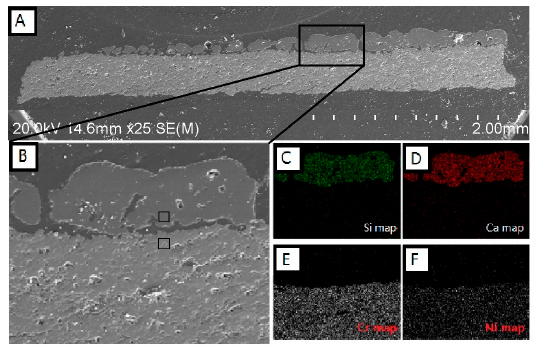
Figure 2. ( A ) Cross-sectional SEM micrographs of APS NiCr 2 O 4 coating that interacted with 35 mg/cm 2 CMAS at 1200 °C for 24 h; ( B ) Higher magnification image of CMAS-NiCr 2 O 4 boundary and its ( C ) Si; ( D ) Ca; ( E ) Cr and ( F ) Ni maps. Table 2. EDS cation compositions (at %) of upper square (residue CMAS) and lower square (edge of NiCr 2 O 4 coating) in Figure 2B.